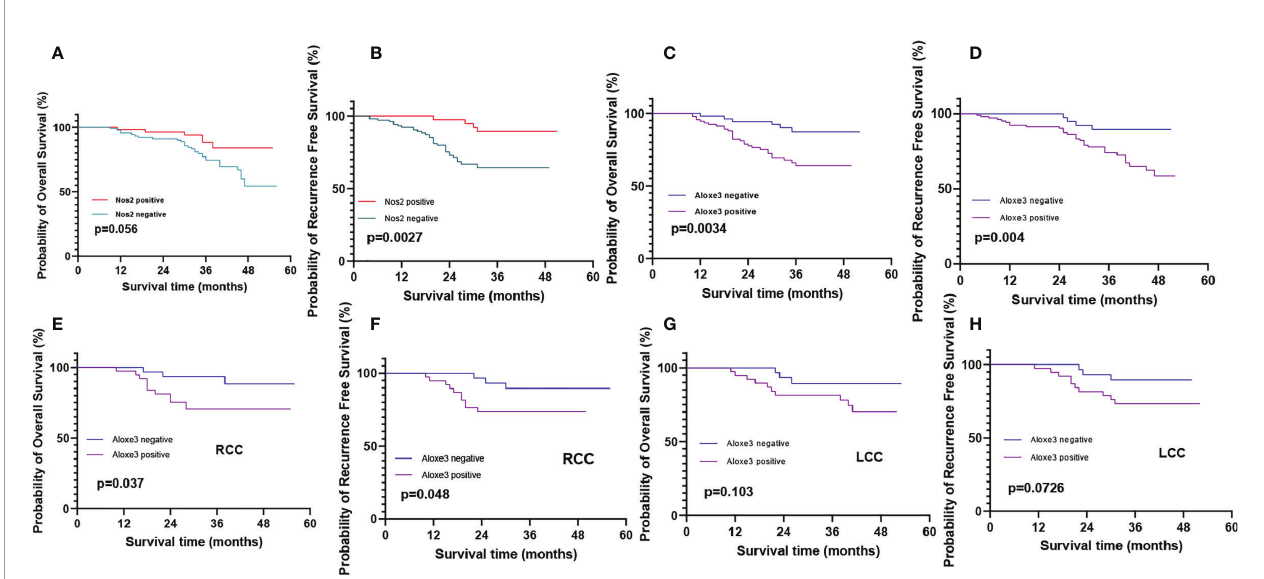
FIGURE 15 | Recurrence-free survival and overall survival curves of patients with positive and negative expression of NOS2 and ALOXE3 in colon cancer. (A, C) Overall survival curves of NOS2, ALOXE3 for all patients. (B, D) Recurrence-free survival curves of NOS2, ALOXE3 for all patients. (E, G) Overall survival curves of RCC and LCC. (F, H) Recurrence-free survival curves of RCC and